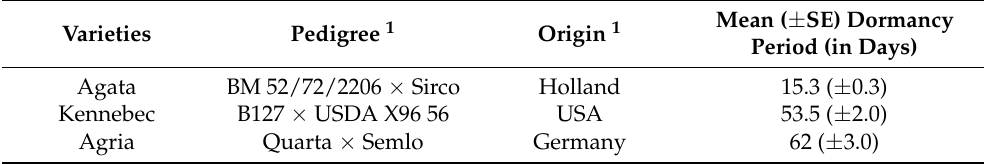
Table 1. Mean length of dormancy period in potato tubers of Agata, Kennebec and Agria cultivars grown under the same conditions in the present